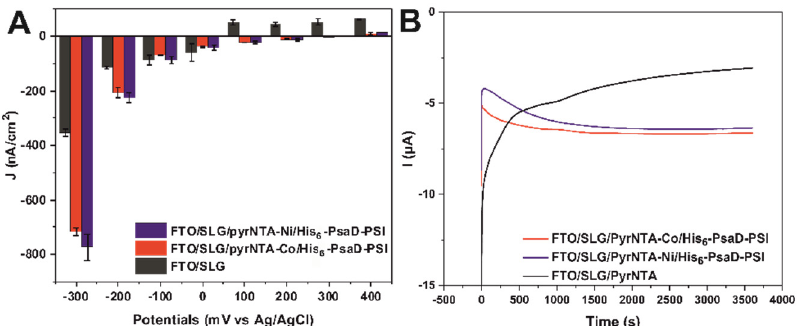
Figure 5. Photochronoamperometric analysis of the biohybrid His 6 -PsaD-PSI based nanoassemblies. ( A ) Photocurrent densities obtained from the freshly prepared FTO/SLG/pyr-NTA-Ni/His 6 -PsaD- PSI and FTO/SLG/pyr-NTA-Co/His 6 -PsaD-PSI samples under 30 s ‘light ON/OFF’ cycles vs. FTO/SLG control. These data were obtained for 2 independent samples (n = 2). ( B ) Photocurrent curves recorded for the representative FTO/SLG/pyr-NTA-Ni/His 6 -PsaD-PSI and FTO/SLG/pyr- NTA-Co/His 6 -PsaD-PSI samples vs. FTO/SLG/pyr-NTA control. Photocurrents were recorded at − 0.3 V during 1 h continuous illumination (100 mW · cm − 2 ).